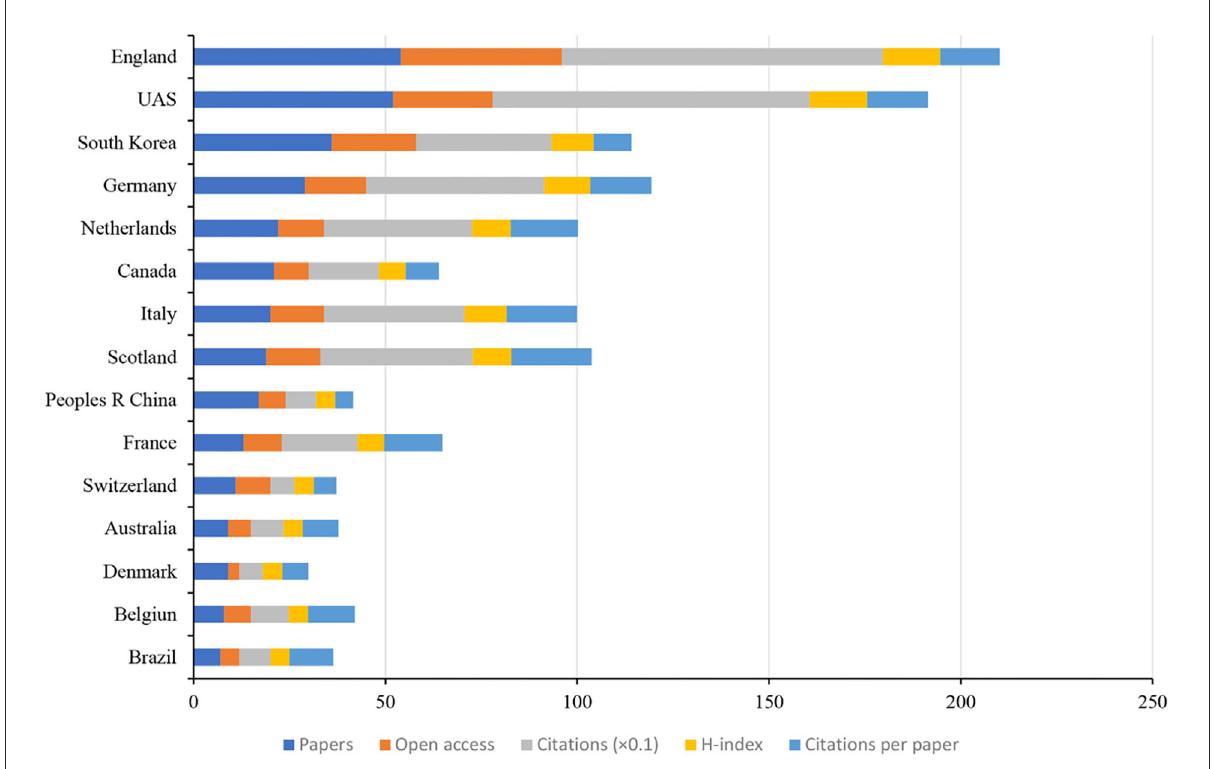
FIGURE7 The number of articles, open-access papers, citations, H-index, and citations per paper of the top 15